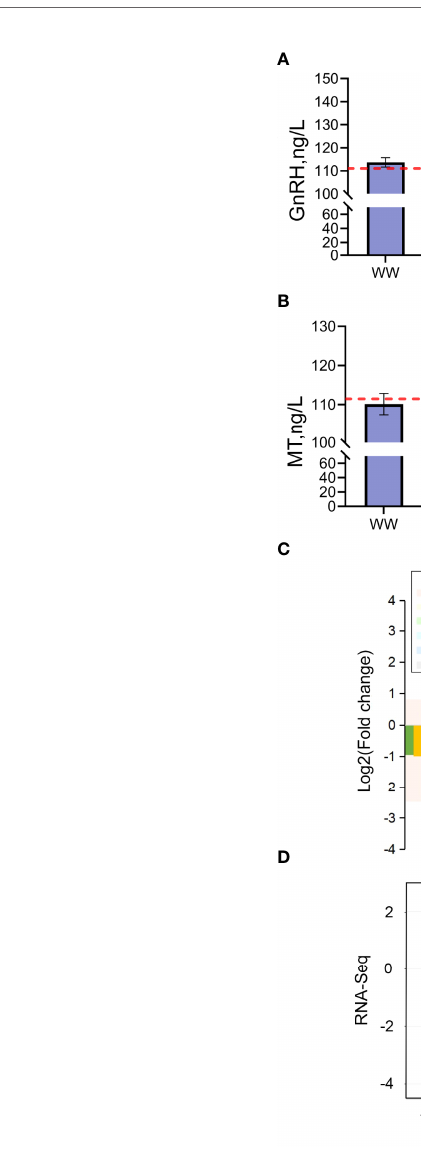
FIGURE 7 | Validation of hormone concentration and gene expression. (A) The content of GnRH. (B) The content of MT. ** indicated adjusted P value less than 0.01. (C) The expression of candidate lncRNAs and mRNAs. (D) Correlation of gene expression level of 13 differentially expressed genes (DEGs) and six differentially expressed lncRNAs (DELs) using RNA-Seq and RT- qPCR. The x- and y- axis represents the log2 (fpkm) measured by RNA-Seq and RT-qPCR, respectively. GAPDH was used as reference gene. The blue and red dots represent the DEGs and DELs,